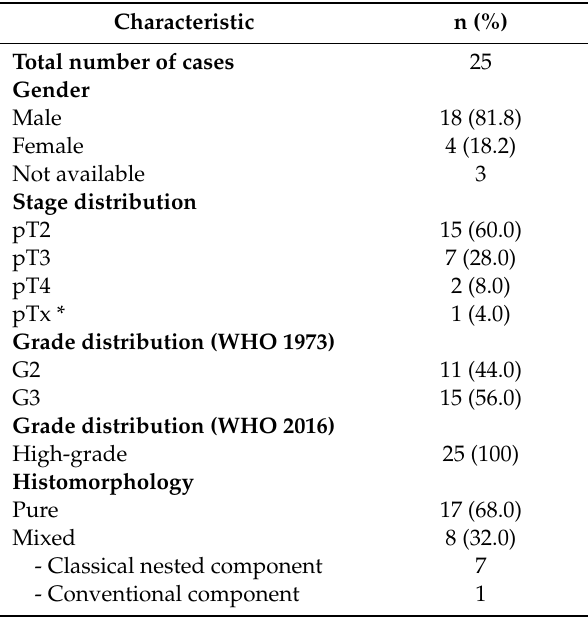
Table 1. Clinical and morphological characteristics.